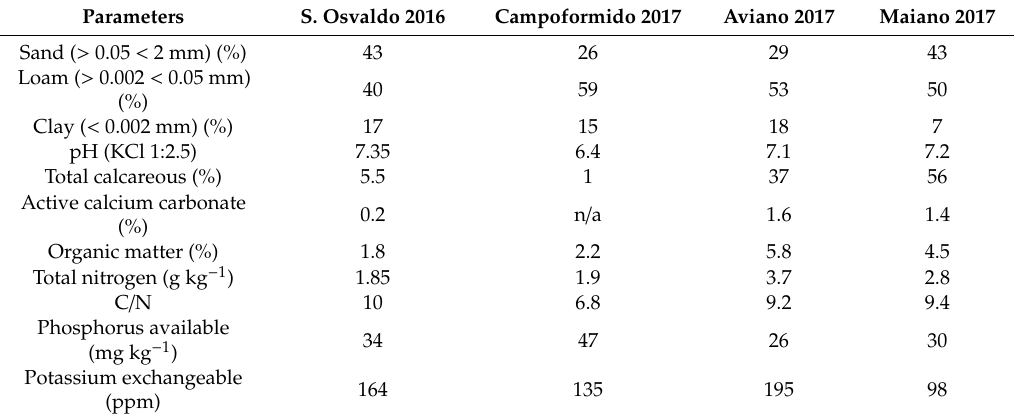
Table 1. Main soil characteristics (0–0.5 m layer).